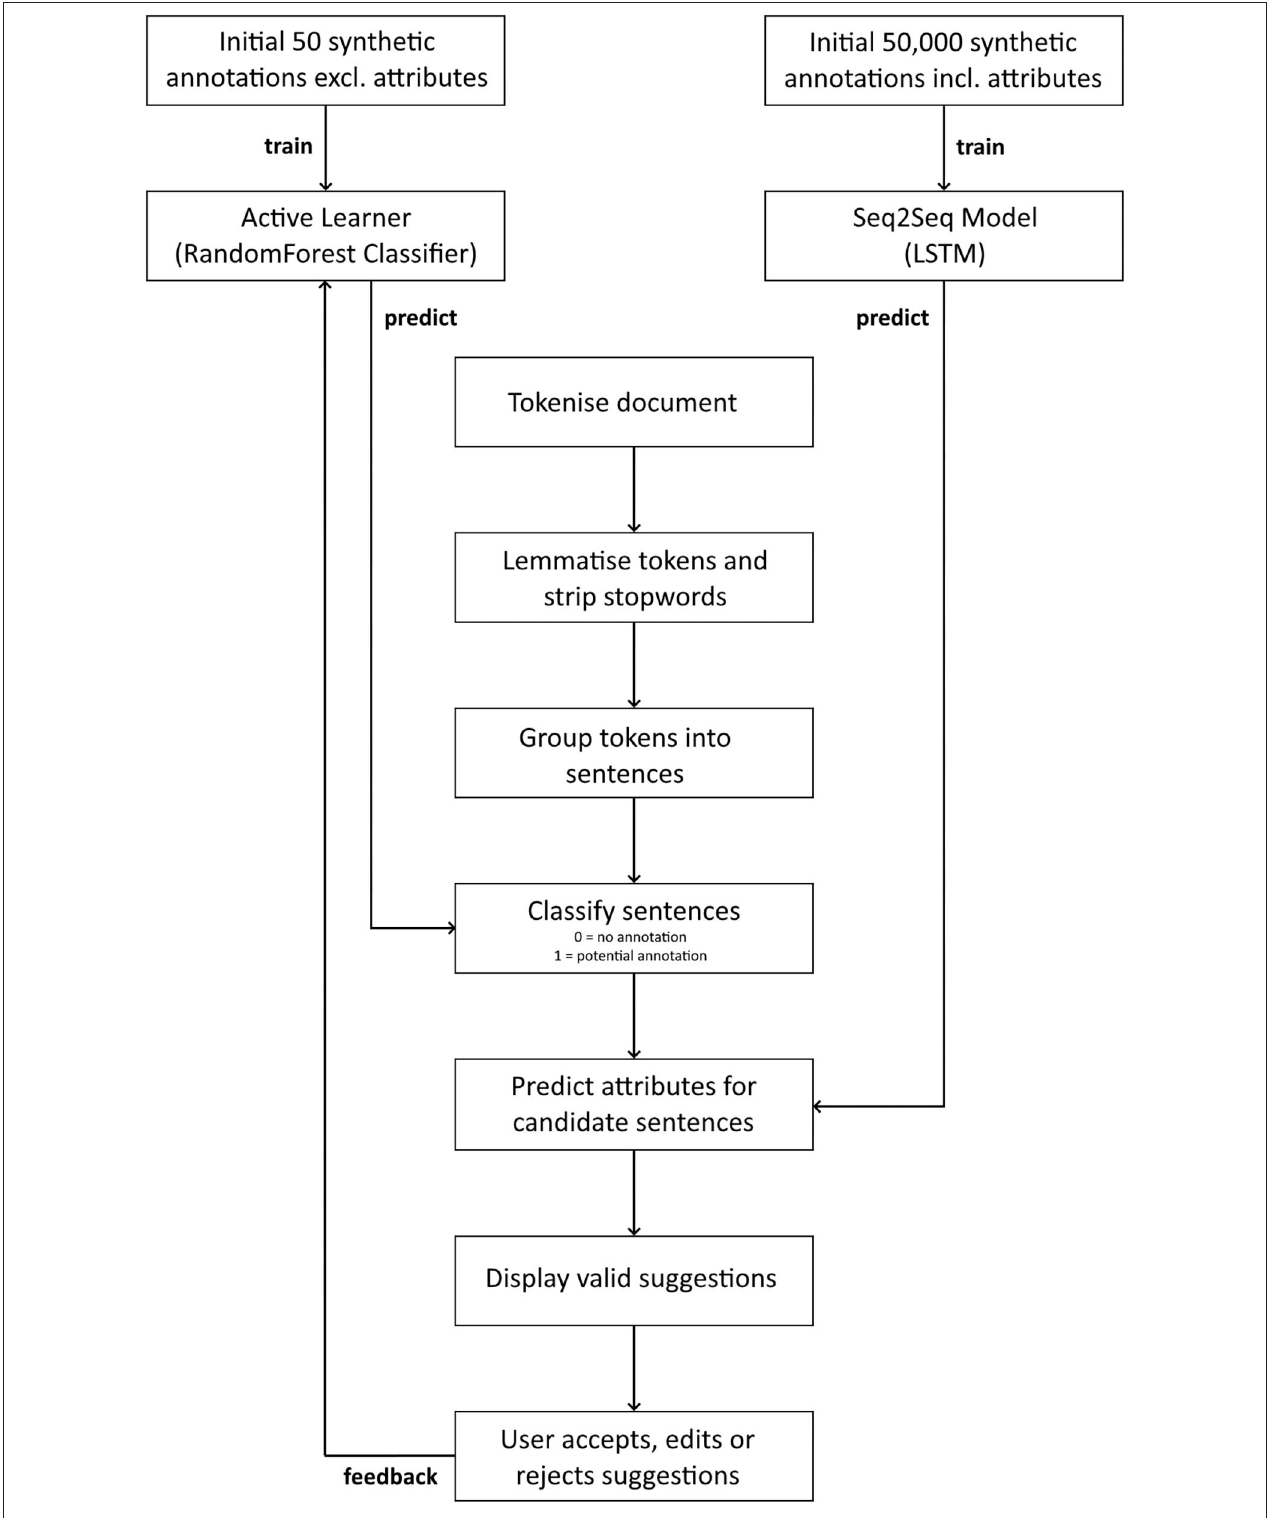
FIGURE 5 | A flow diagram of the annotation suggestion process. Named Entity Recognition is performed using an Active Learner with an underlying Random Forest classifier, and sentence to attribute conversion is performed using an LSTM-based Sequence-to-Sequence model.